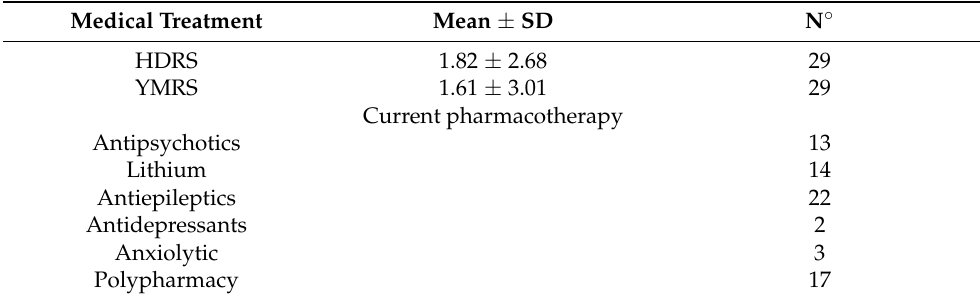
Table 3. Clinical details regarding the BD group. Medical